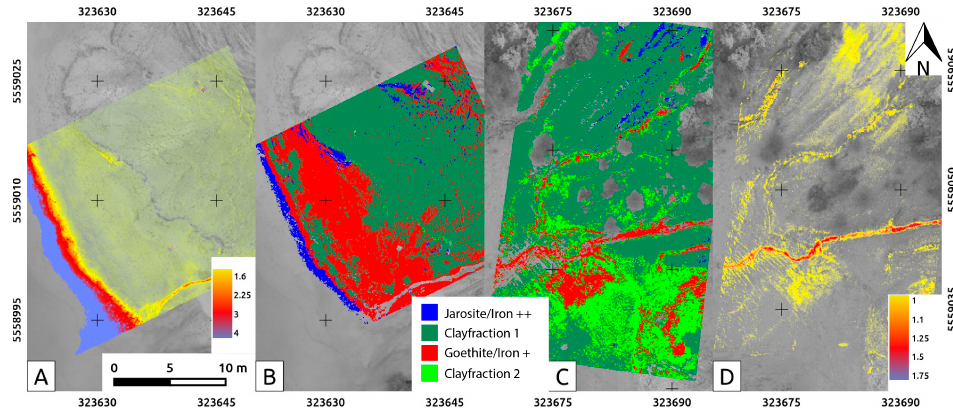
Figure 8. Results of two different classification approaches of two scenes, May 2016. Frames ( A , B ) display a waterfront scene, with band-ratio calculation and SAM classification, respectively. Frames ( C , D ) display the northern slope of the Litov area, first the SAM classification ( C ) followed by the band ratio ( D ). The endmember legend applies to ( B , C ). The legend in ( A , D ) is the dimensionless band-ratio of 720/880 nm.